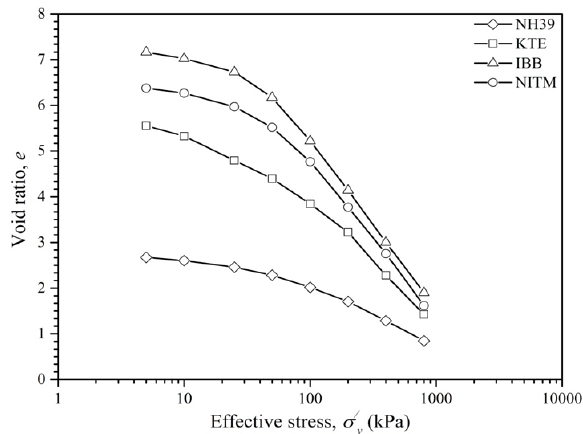
Figure 6. Time-settlement curves for Northeast Indian peats.